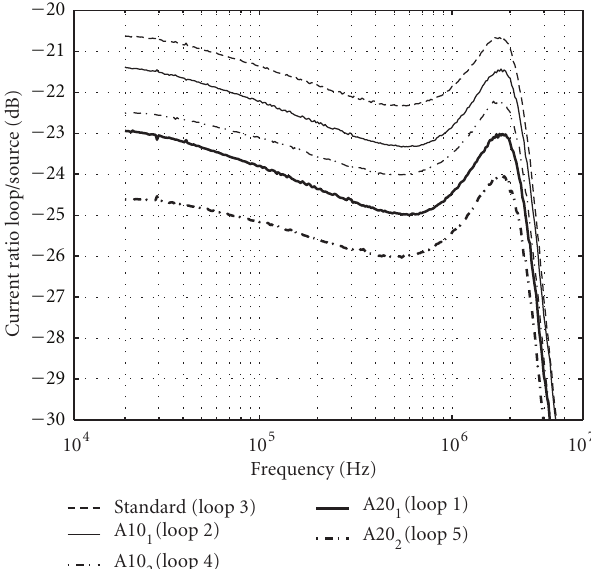
Figure 6: Quadrupole dB current ratio, sensor Q 10 1 (loop 2).